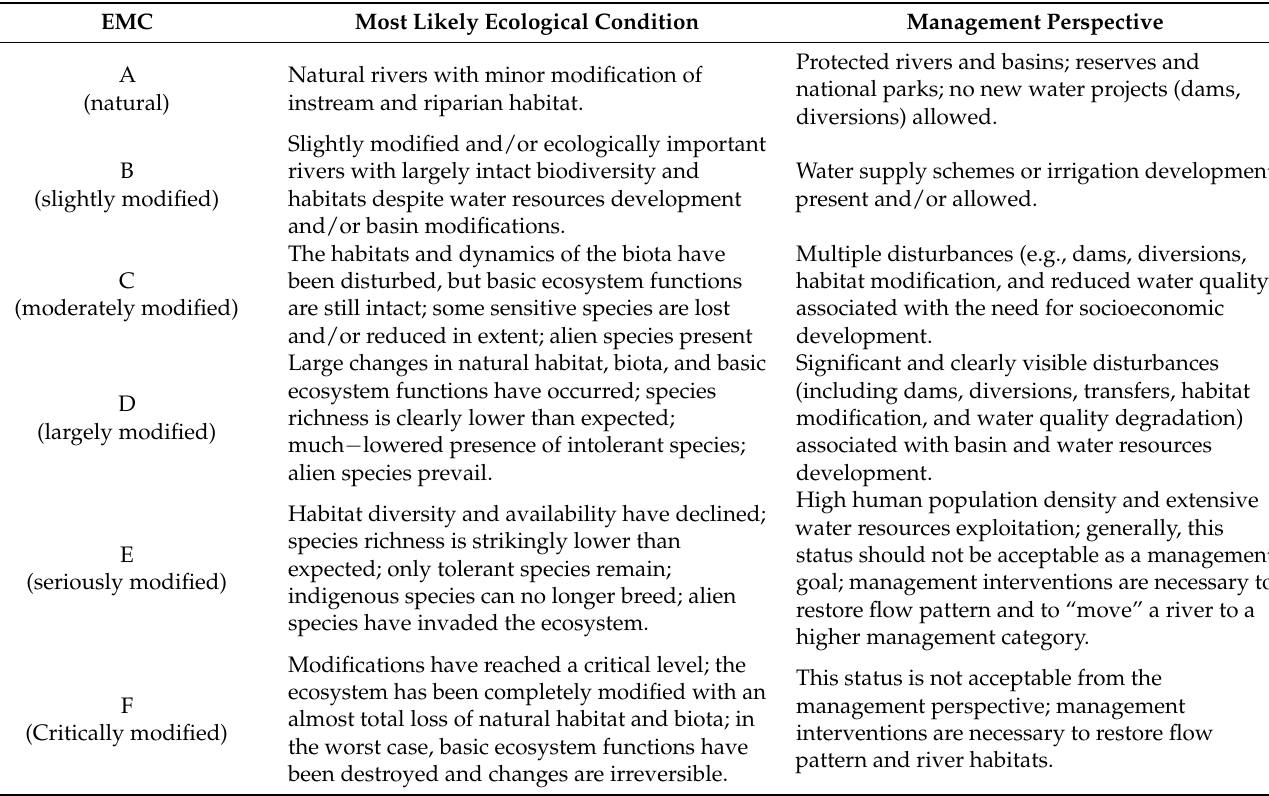
Table 2. Environmental Management Classes derived from the GEFC